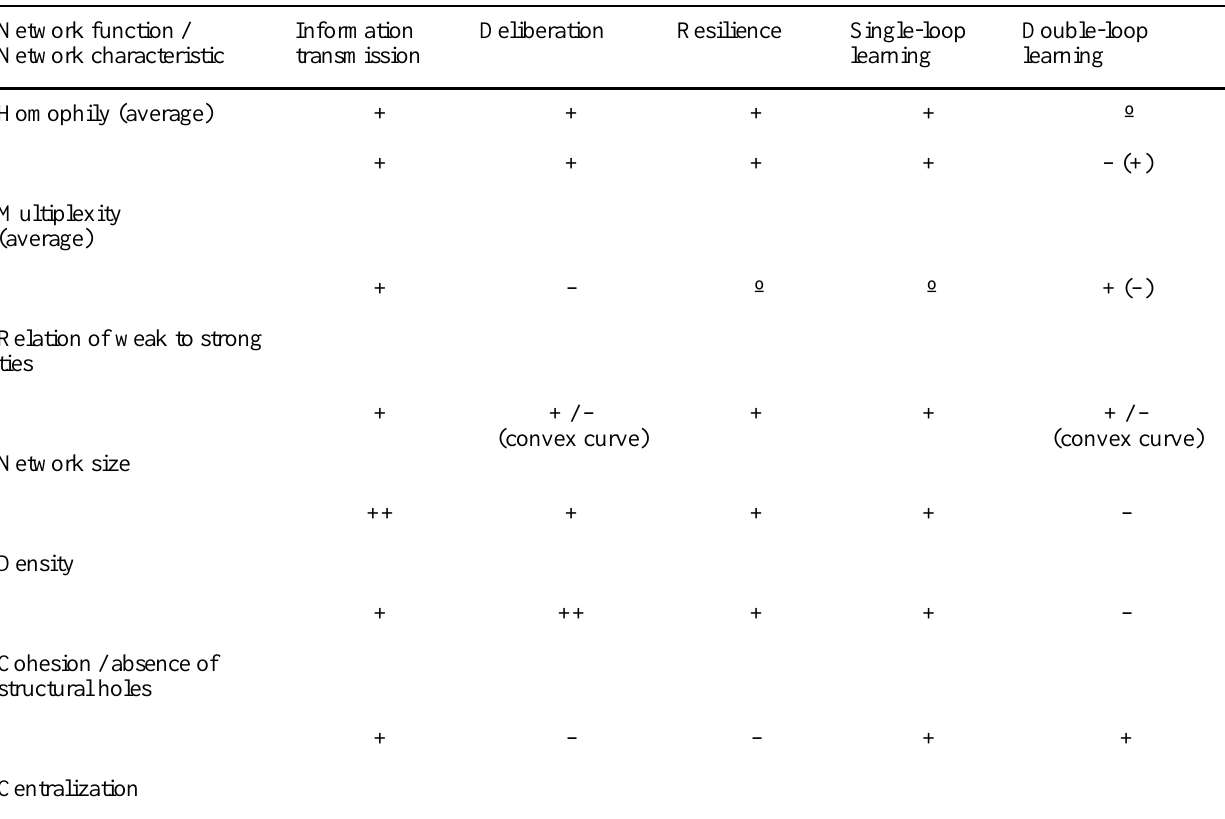
Table 2 . Hypothesised influence of network characteristics on the performance of network functions. Network function / Information Deliberation Resilience Single-loop Network characteristic transmission